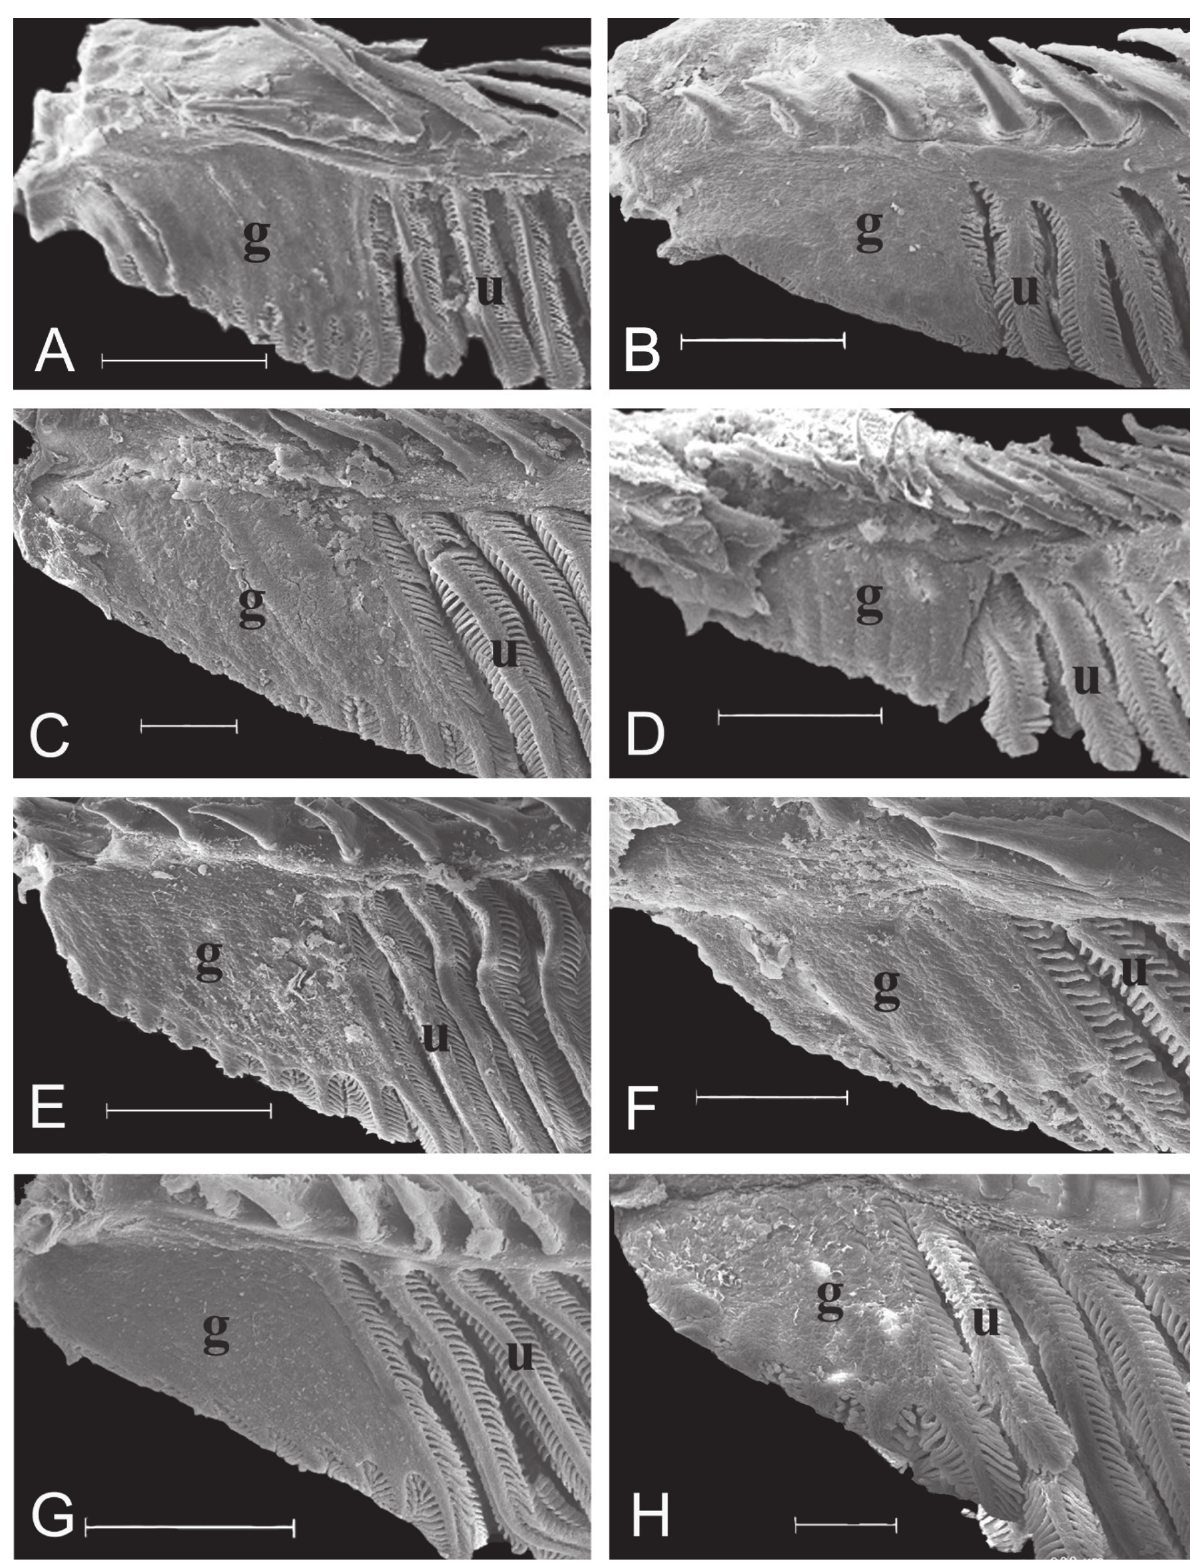
Fig. 2. Scanning electron micrographs (SEMs) of first left gill arch of male externally fertilizing cheirodontines, ( A ) Aphyocheirodon hemigrammus , ( B ) Cheirodon ibicuhiensis , ( C ) Cheirodontops geayi , ( D ) Heterocheirodon yatai , (E) Odontostilbe fugitiva , ( F ) Nanocheirodon insignis , ( G ) Prodontocharax melanotus , and ( H ) Serrapinnus heterodon . Gill glands (g), unmodified gill filaments (u). Scale bars: 200 µm (A, B, C, D, H), 500 µm (E,